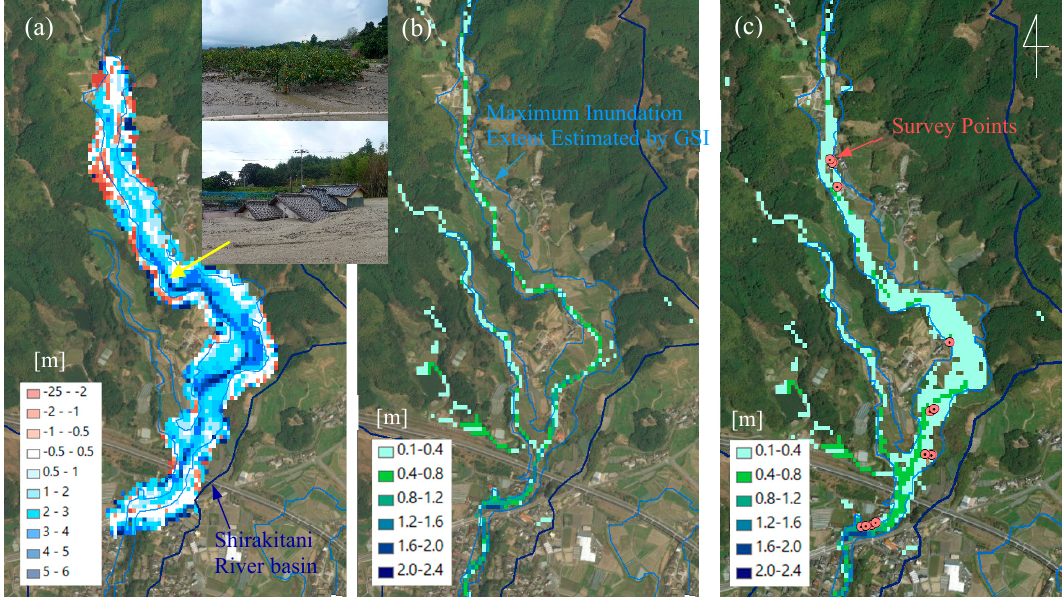
Figure 13. In the downstream part of the Shirakitani River basin: ( a ) Topographical change (Difference between the DEM by mobile mapping system (MMS) after the disaster and DEM by the Geographical Survey Institute before the disaster), maximum inundation depth distribution estimated by the RRI model ( b ) with the original DEM and ( c ) with the new DEM created by the PB analysis.